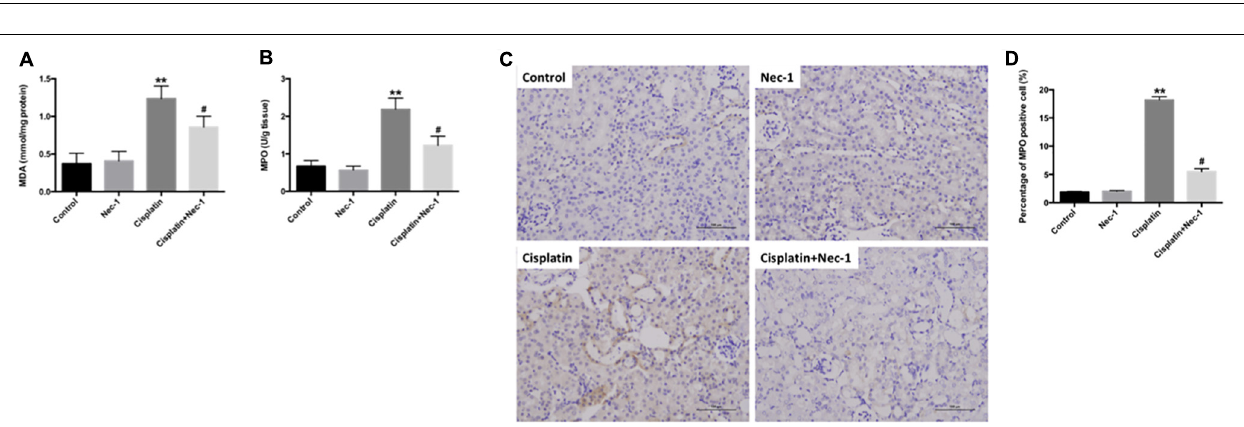
FIGURE 3 | Nec-1 reduces inflammation in cisplatin-induced nephrotoxicity. (A,B) The NF κ B signaling related proteins of p-IKK α / β , p-I κ B, and p-NF κ B p65 tested by western blotting were activated in the cisplatin-induced group ( ∗ p < 0.05, ∗∗ p < 0.01 versus control group). The administration of Nec-1 significantly ameliorated these effects following cisplatin insult (# p < 0.05, ## p < 0.01 versus cisplatin group). (C) IHC staining showed that the positive areas for NF κ B were mainly located in tubular epithelial cells from the cisplatin-induced kidneys. (D) The proinflammatory cytokines mRNA levels of IL-1 β , IL-6, TNF- α , and CCL5 tested by real-time RT-PCR were much greater in the cisplatin group compared with the control group ( ∗ p < 0.05, ∗∗ p < 0.01). The administration of Nec-1 strongly ameliorated inflammatory factors (# p < 0.05 versus cisplatin group).